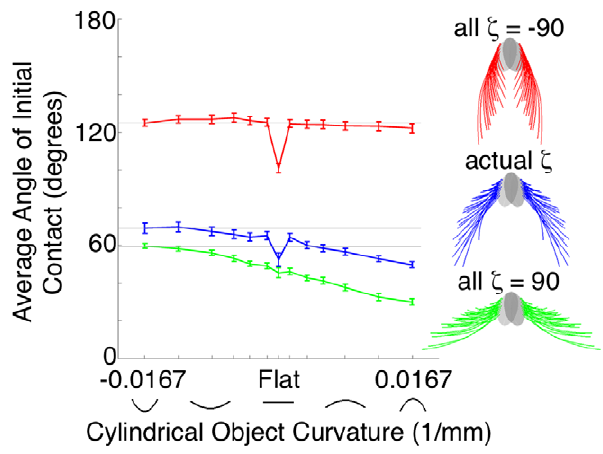
Figure 12. Effect of array morphology on information available to the nervous system. Average angles of initial contact with cylinders of varying curvatures were calculated for each array morphology. If all whiskers are oriented concave forward ( f = + 90, green), the relationship between the average angle of contact and the object curvature is mostly a shifted version of the relationship obtained for the actual morphology (blue). If all whiskers are oriented concave backwards ( f = 2 90, red), the functional relationship changes dramat- ically. No significant relationship exists between the angle of initial contact and object curvature. Gray lines show the value of the mean angle of contact for the largest negative curvature for each morphology, and are intended to guide the